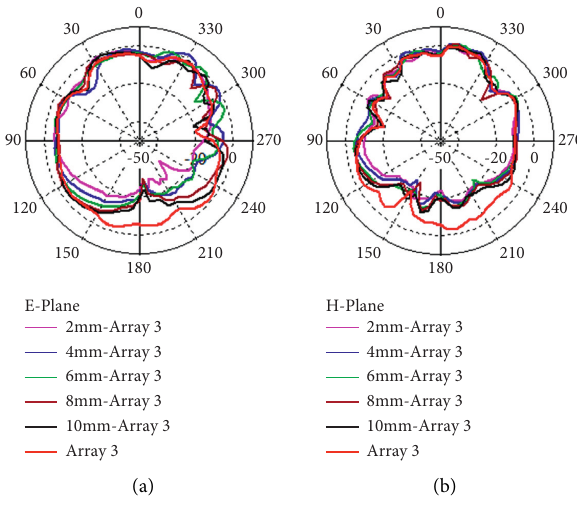
Figure 27: Array 3 on-body radiation pattern at 60GHz. (a) E-plane. (b) H-plane.